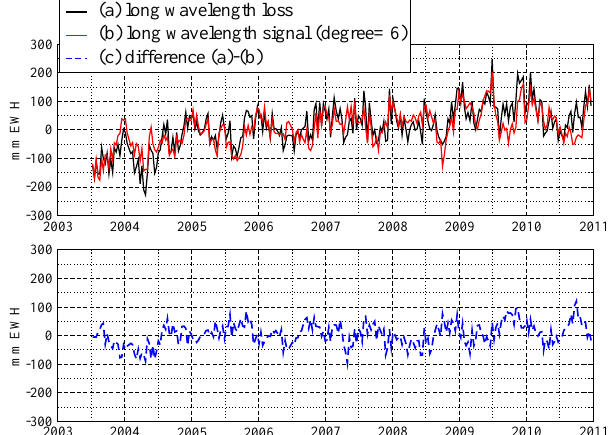
Fig. 2. Water mass time series averaged over Australia: (a) difference between regional and GRGS solutions, (b) GRGS GRACE solutions up to degree 6, and (c) their difference (RMS value 39mm).